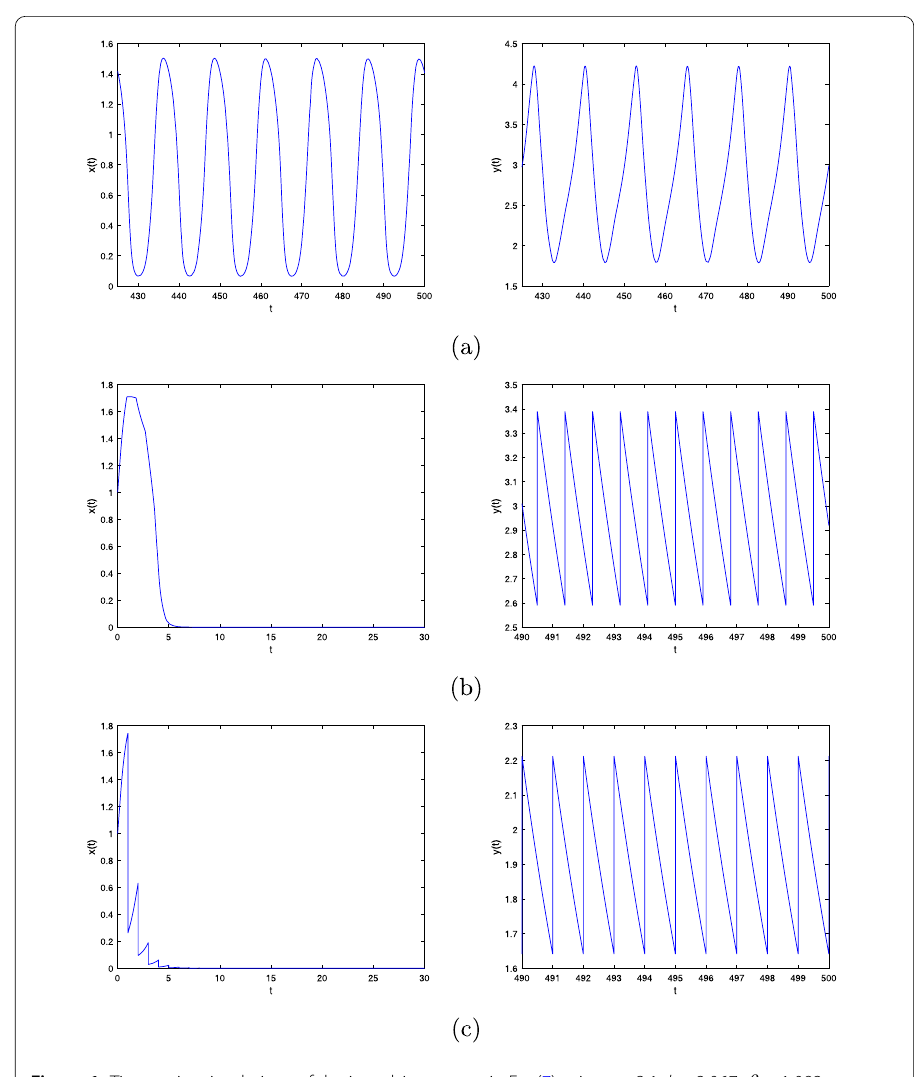
Figure 1 Time series simulations of the impulsive system in Eq. (7) using r = 3.1, k = 2.067, β = 1.083, a = 1.031, b = 0.001, μ = 0.85, d = 0.3, η = 0.01: ( a ) without taking any impulsive control strategy ( p 1 = p 2 = p 3 = 0) when ( x (0), y (0)) = (0.5,0.5) and T = 13; ( b ) with only releasing the predators ( p 1 = p 2 = 0, p 3 = 0.8) when ( x (0), y (0)) = (1,1) and T = 0.8 < T max = 0.9; ( c ) with applying the IPM strategy ( p 1 = 0.85, p 2 = 0.2, p 3 = 0.9) when ( x (0), y (0)) = (1,1) and T = 1 < T max = 1.335